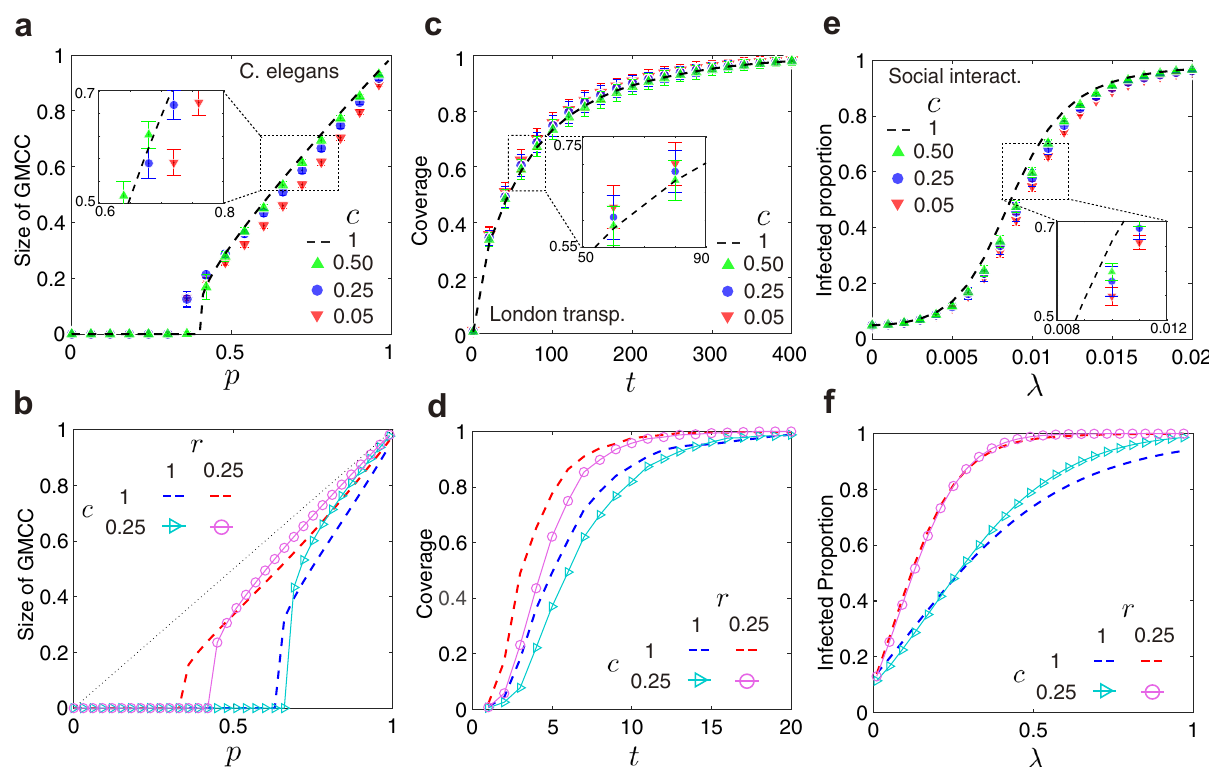
Fig. 6 The performance of dynamic prediction. a The percolation processes of the reconstructed multiplex network corresponding to different fraction of partial observation c = 0.05,0.25, 0.5, and the real multiplex network ( c = 1) for C. elegans multiplex connectome. The x -axis denotes the occupied probability p and the y -axis denotes the size of GMCC (giant mutually connected component) when nodes are randomly removed with probability 1 − p in one layer. b The impact of ratio of average degrees r on the percolation process for r = 0.25 and r = 1. c A random walk process taking place on the reconstructed multiplex network and real multiplex network for London transportation network. The x -axis denotes time t and the y -axis denotes coverage (the fraction of nodes that have been visited before a certain time) of n walkers starting from a set of random chosen nodes. d The impact of r on random walk process for r = 0.25 and r = 1. e The spreading process on the reconstructed temporal network and real temporal network for the social interactions at the SFHH conference. The x -axis denotes the infection rate λ and the y -axis denotes the infected fraction. f The impact of r on spreading process for r = 0.25 and r = 1. The error bar indicates standard deviation in this fi